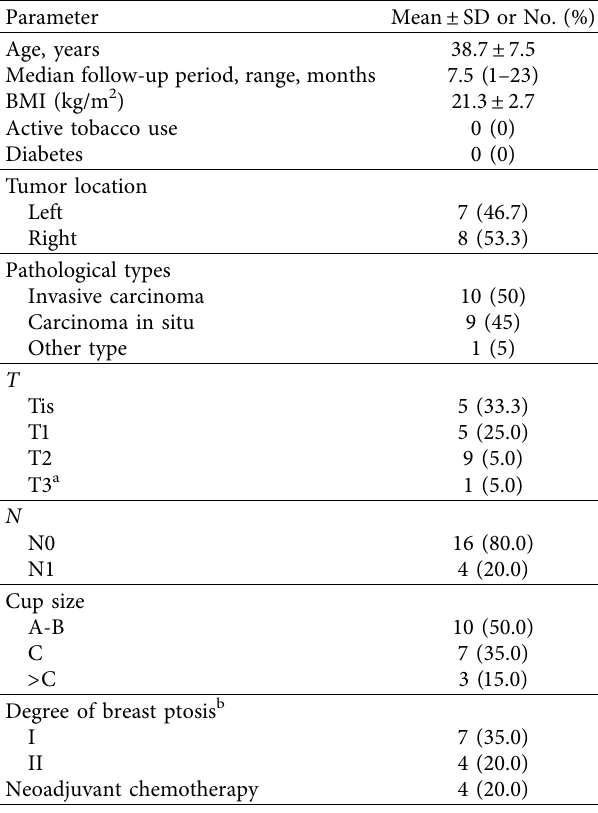
Table 1: Clinical characteristics of the